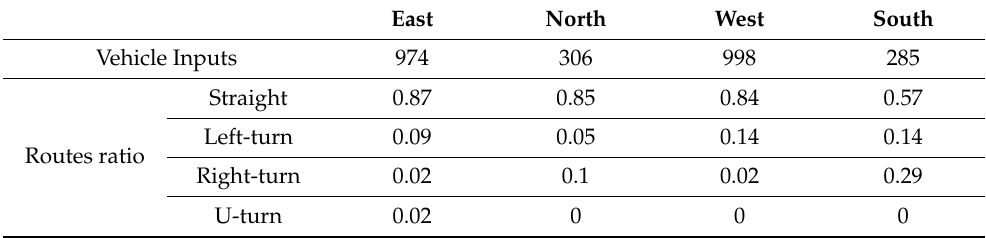
Table 2. The vehicle inputs and routes ratio of VISSIM.